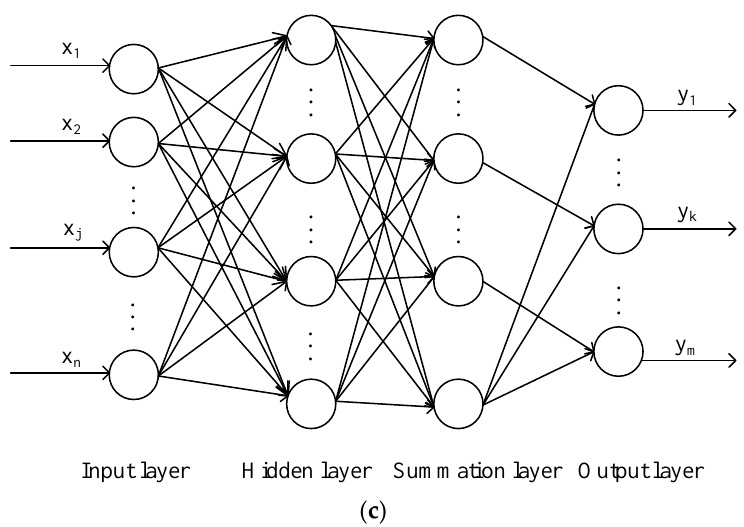
Figure 2. Multi-input-multi-output architectures of: ( a ) back-propagation neural networks (BPNN); ( b ) radial basis function networks (RBFNs); and ( c ) general regression neutral networks (GRNNs).